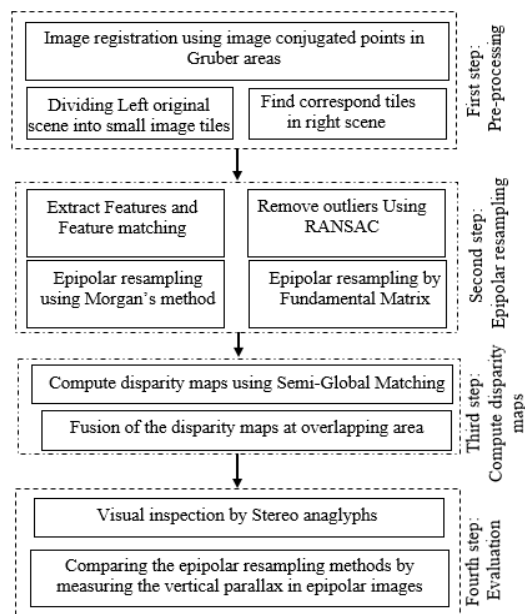
Figure 4. Flowchart of proposed method to create epipolar image as input of SGM